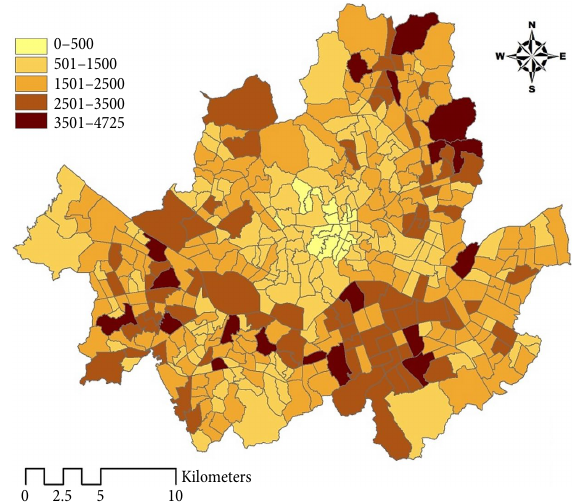
Fig. 2. Distribution of the WND program